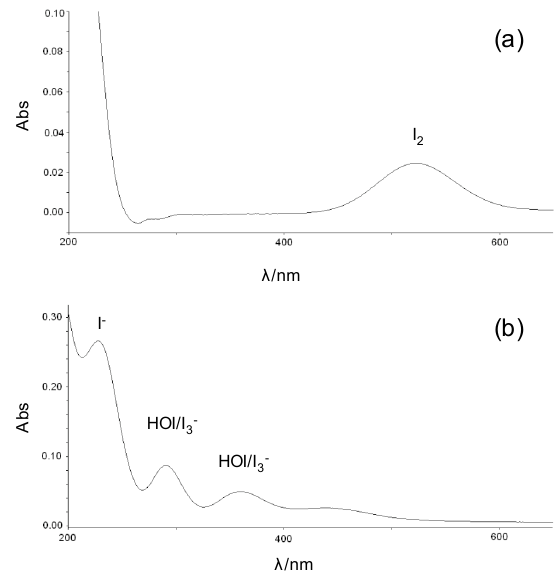
Fig. 1. Absorption spectrum of (a) 5 × 10 − 5 M molecular iodine in n -hexane and (b) 5 × 10 − 5 M molecular iodine in